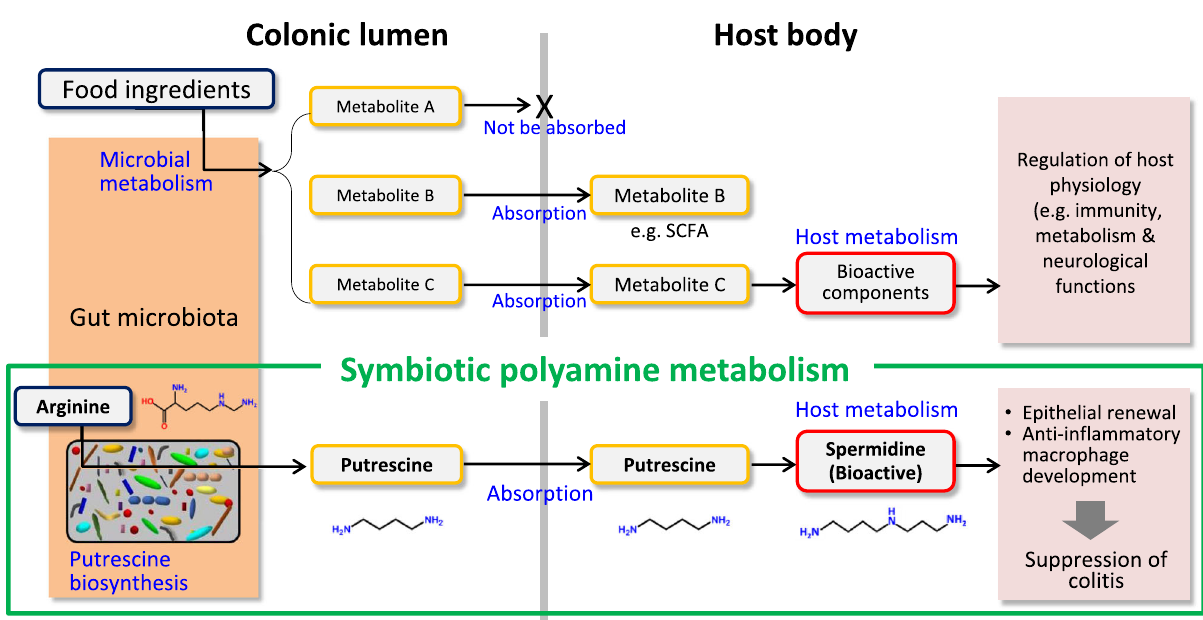
Fig. 6 Symbiotic metabolism. Low-molecular metabolites produced by the intestinal microbiota remain in the lumen (Metabolite A) or are absorbed from the intestinal lumen to systemic circulation (Metabolite B and C). Metabolite B, which are represented by short-chain fatty acids, directory act on host